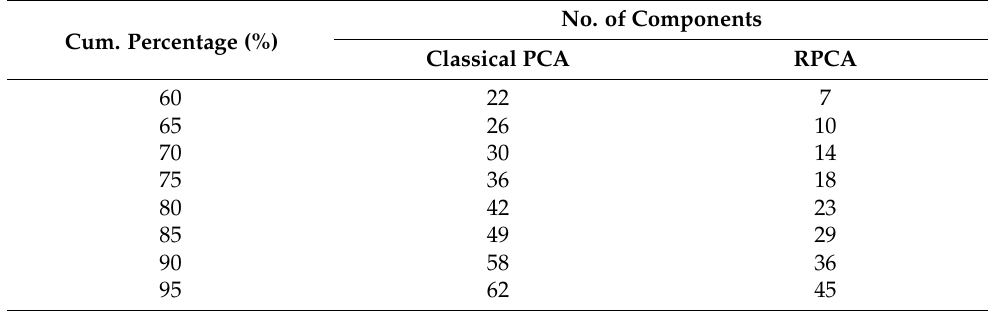
Table 4. Number of components obtained for classical PCA against RPCA for the original rainfall data. Cum. Percentage